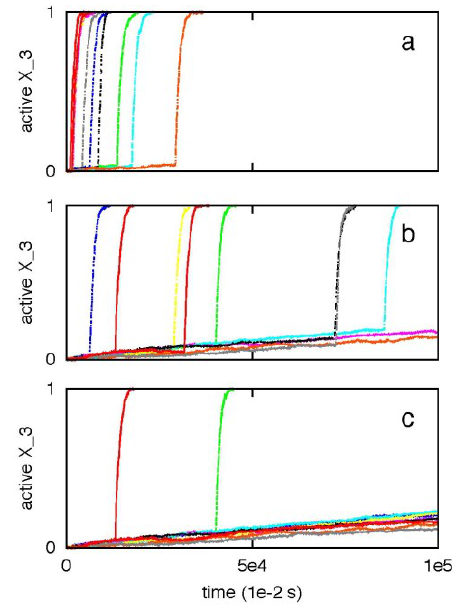
Figure 10. The effect of variation in the rate constant for the slow step ( X studied for the following values: 10 −6 ( a ), 10 −7 ( b ), and 10 −8 ( c ). The minimal network